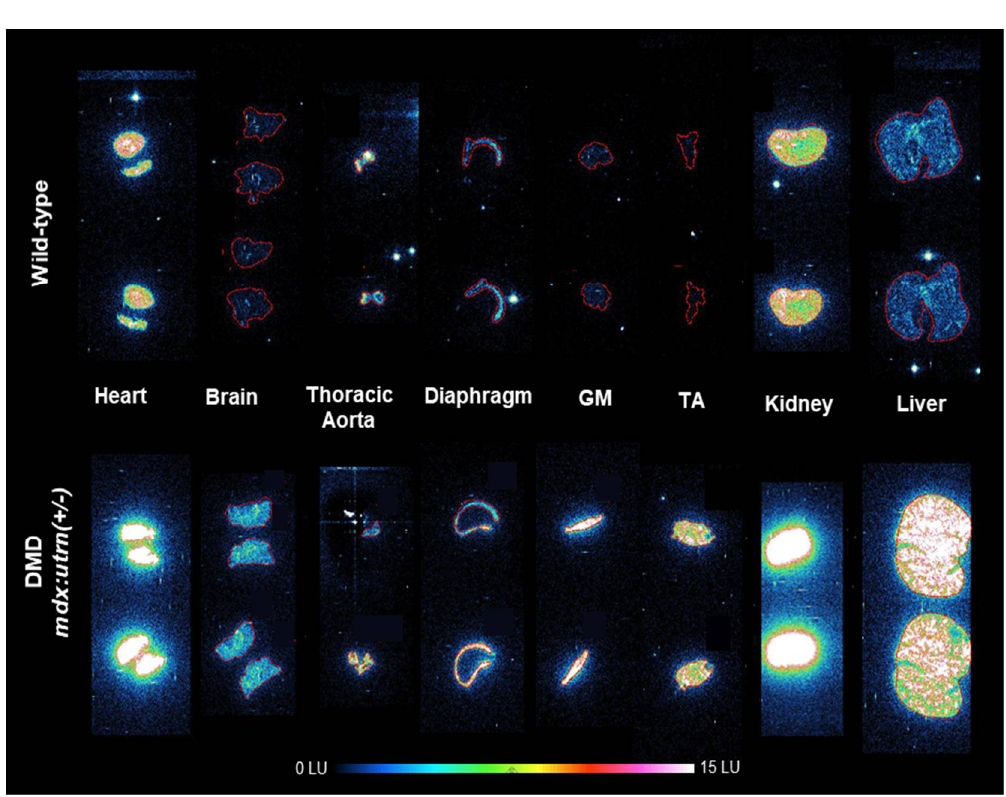
Figure A1. Autoradiography images of the heart, brain, and multiple tissues excised from a repre- sentative MDX and wild-type mice injected with [ 18 F]FEPPA. LU = light units. MDX = dystrophin- deficient mdx:utrn (+/−) mouse models.